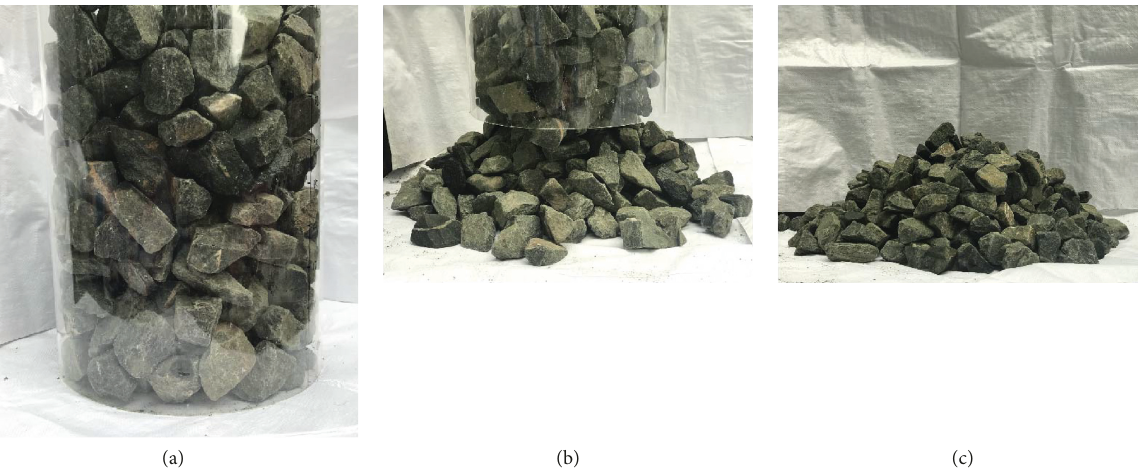
Figure 2: The process of the cylinder lifting test. (a) Before lifting. (b) Middle of lifting. (c) After lifting.